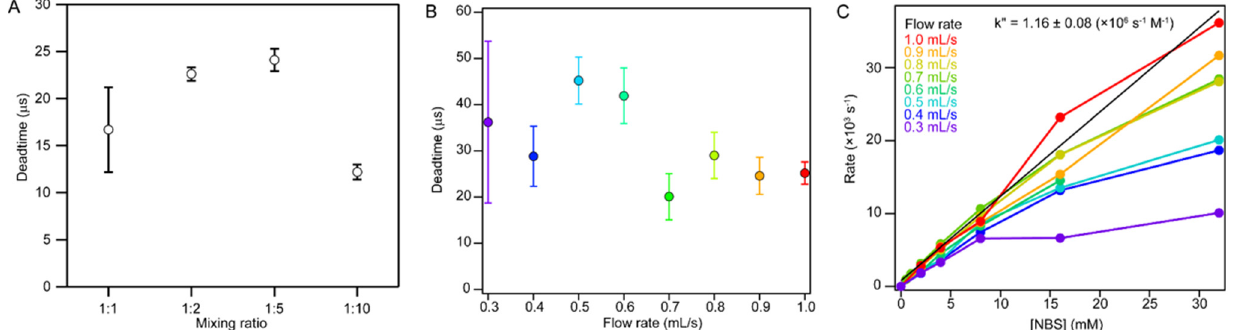
Figure 4. Optimization of mixing ratio and flow rate for Mixer 3. ( A ) Mixing ratio dependence and ( B ) flow rate dependence of dead time. ( C ) The NBS concentration dependence of rate constant obtained at several flow rates. The color code is shown in panel C.